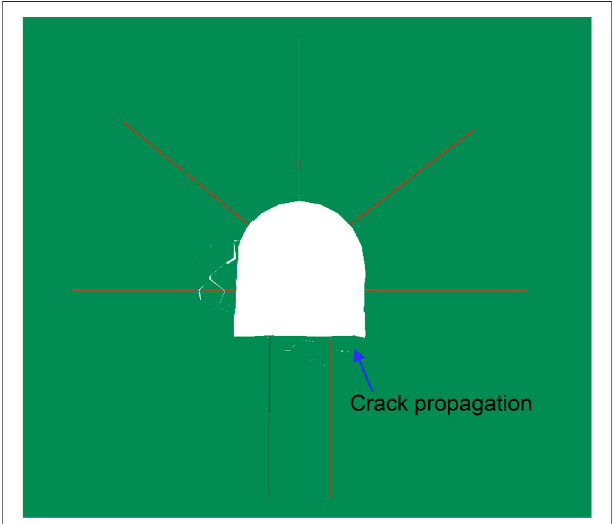
FIGURE 12 | Final failure mode of roadway after SCCM technique was implemented.